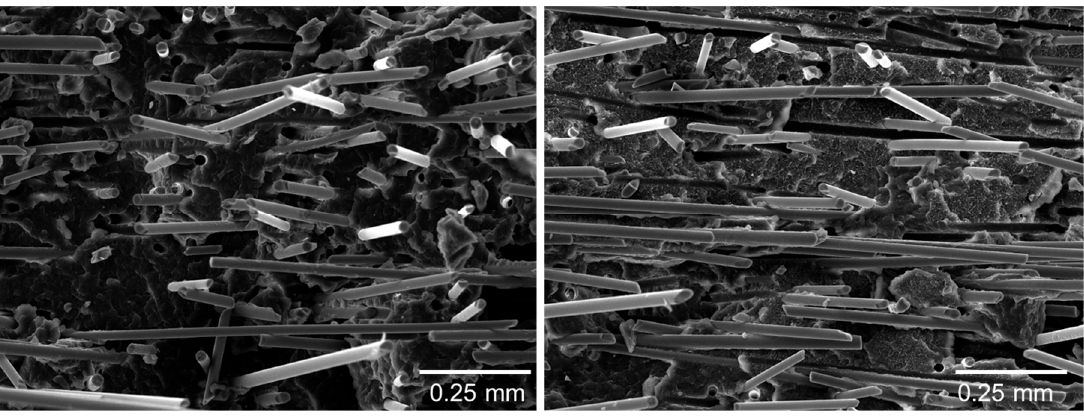
Figure 12. The 30% LFT sample has longer fibers at the tensile breakage surface (higher tensile strength) than 30% regrind sample.